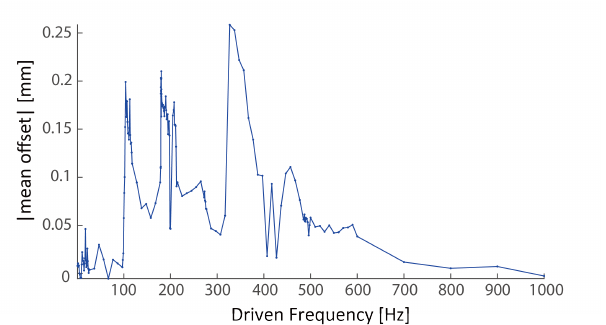
Figure 11. Absolute mean output offset versus PZT bender input